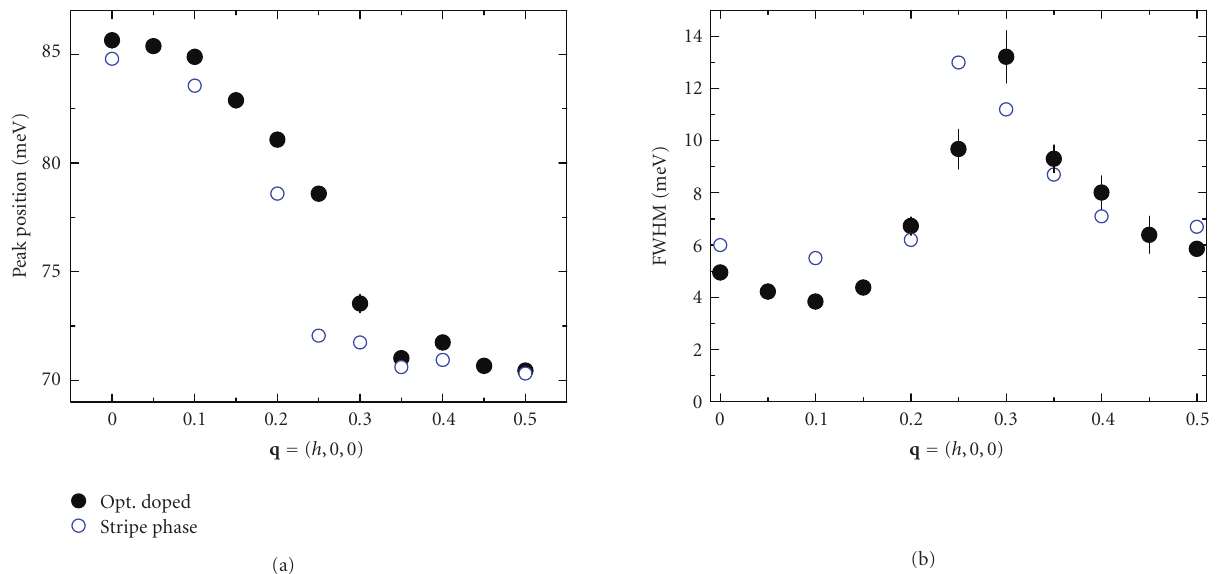
Figure 19: Comparison of the phonon dispersions (a) and linewidth (b) of the bond-stretching branch in La 1 . 85 Sr 0 . 15 CuO 4 and La